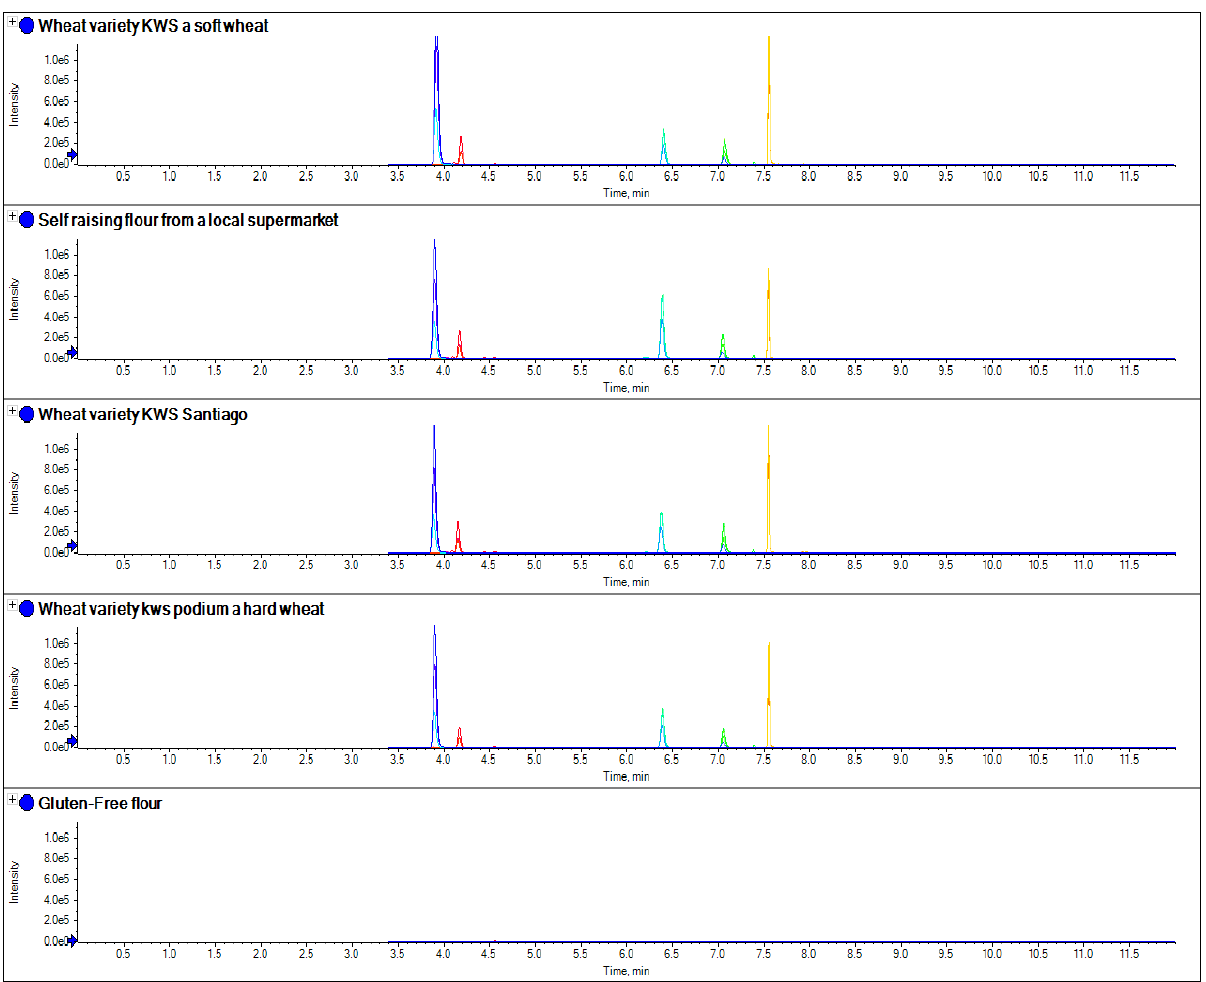
Figure 7. The comparison of separate extracts of several samples of wheat obtained from single variety grain samples, as well as a sample of gluten-free flour and self-raising flour obtained from a local supermarket using the wheat peptides in Table